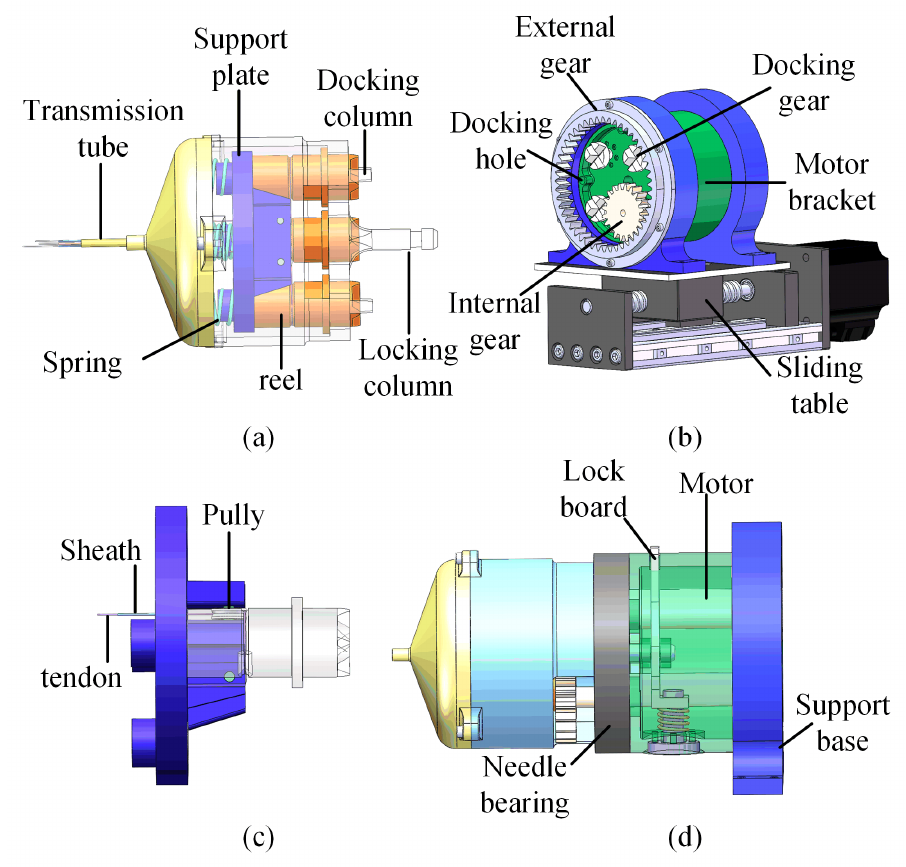
Figure 3. The driver system and transmission system. ( a ) Transmission system of the manipulator; ( b ) driver system of the manipulator; ( c ) close-up view of one tendon and reel configuration; ( d ) close-up view of the detachable mechanism.